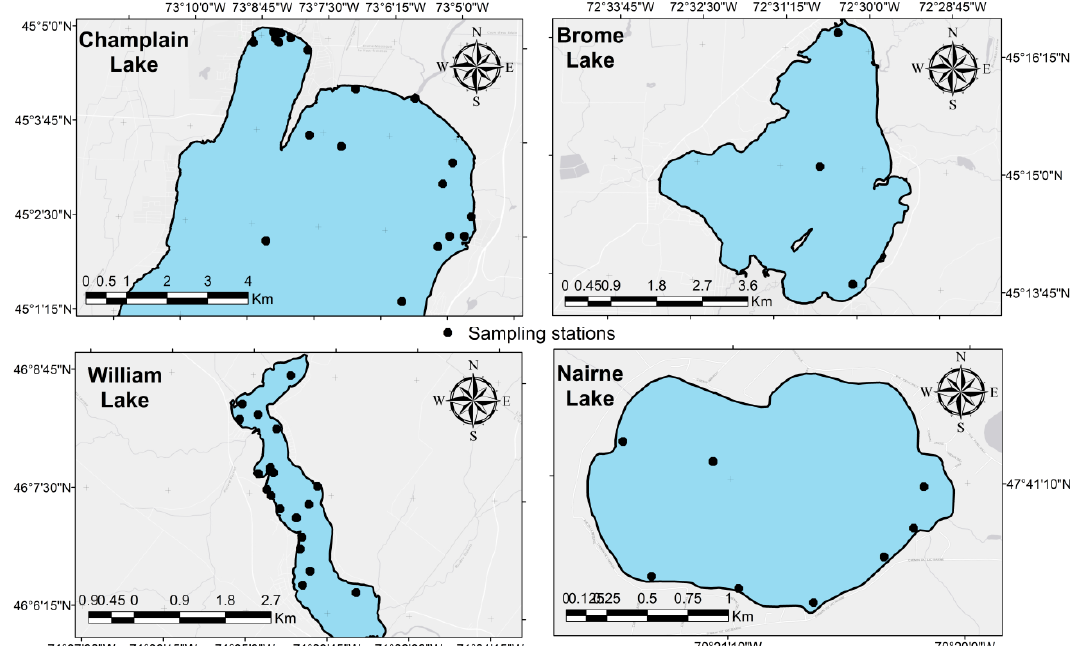
Figure 2. Water sampling stations on the four studied lakes used for